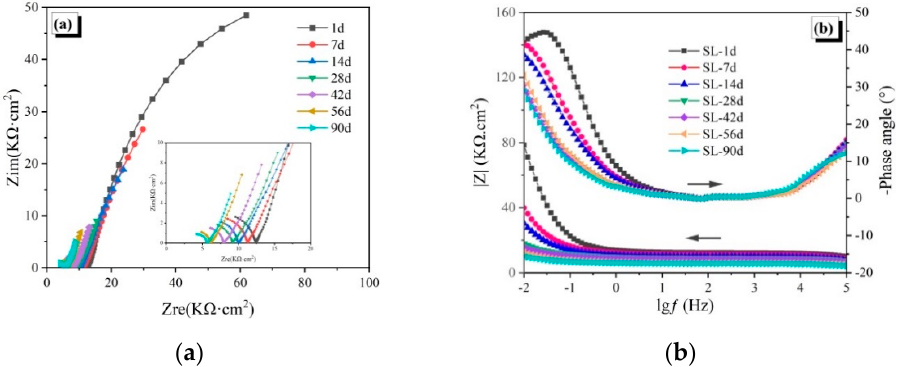
Figure 4. Electrochemical impedance spectroscopy of the SL-30 specimens: ( a ) Nyquist curves, ( b ) Bode curves.